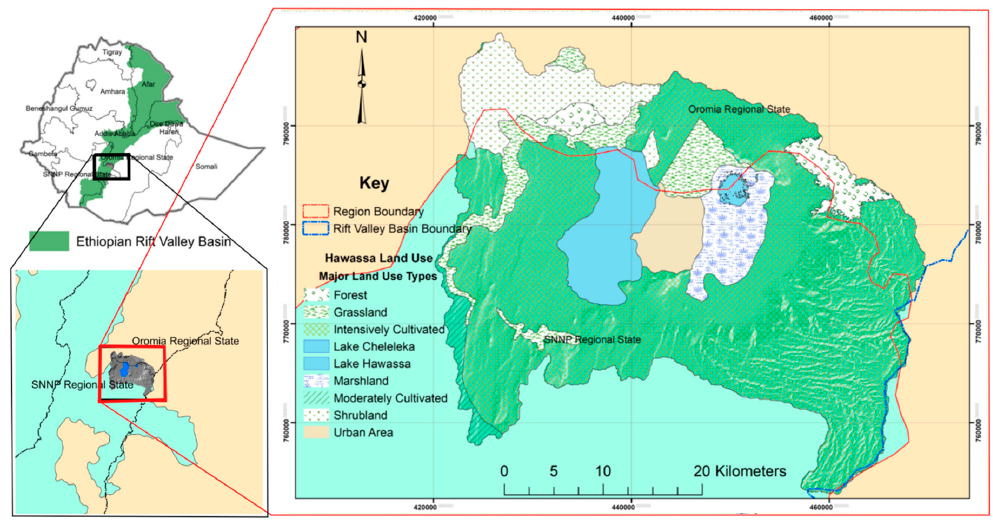
Figure 1. Location map of Lake Hawassa and Lake Cheleleka.